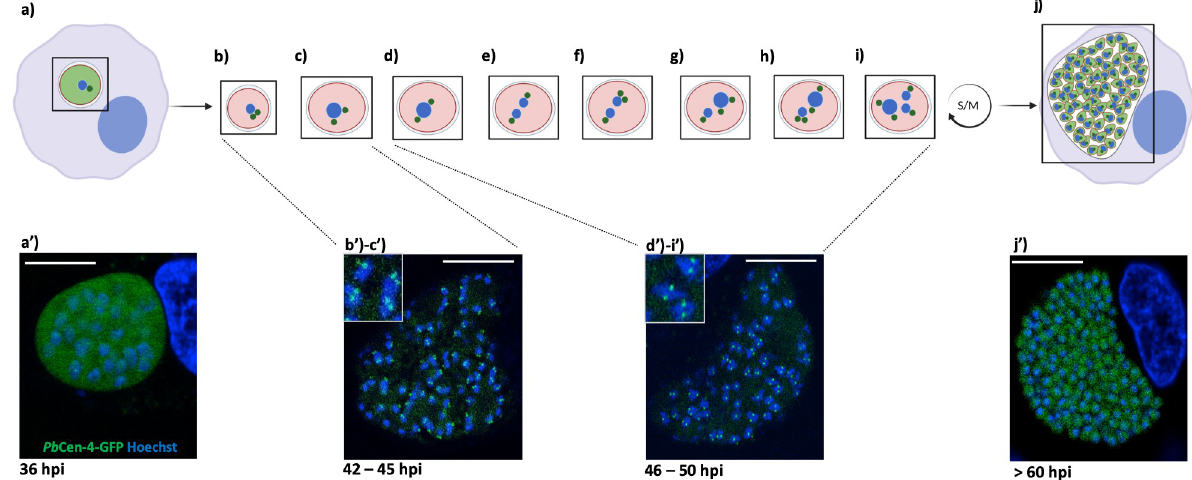
Fig 4. Schematic representation of CPs with Pb Cen-4-GFP and nucleus behavior during LS Plasmodium schizogony. The scheme from (a) to (j) represents Plasmodium nuclear and CP duplication and division through LS schizogony. Individual intracellular Plasmodium EEF (pink, from (b) to (i) ; green light in (a) and (j) ) surrounded by the PVM (light gray) within a hepatocyte (light blue) and the parasite CP (dark green) that is represented as a dot proximal to the parasite nucleus (blue). Corresponding live cell confocal images to this scheme represent prominent Plasmodium LS developmental stages (hpi: hours post-sporozoite infection into host cell): as early schizont (a’) , progression of schizogony (mid-schizogony) from (b’) to (c’) , late schizogony/beginning of cytomere stage from (d’) to (i’) , and finally end of merogony (merozoites formation) (j’) . These images represent endogenous tagging of Pb Cen-4 (PBANKA_0941400, CP marker) in fusion with a GFP fluorescent marker at its C-terminus (GFP, green) during LS development. Parasite and host cell nucleus are stained with Hoechst 33342 (blue). The transgenic parasite line has been generated previously [8]. HeLa cells were infected with Pb Cen-4-GFP expressing salivary gland sporozoites. Images represent the progression of Plasmodiu m nuclear division through schizogony. For a better comprehension, 2 S/M asynchronous rounds where an early schizont stage duplicates its CP have been presented (b); the 2 CPs move at the opposite part of the starting duplicating nucleus (c), (d), from (b’) to (c’) and from (d’) to (i’) to finally be present as a dot close to each individual separated nuclei (e). The S/M alternative phases (represented by the arrow) are then repeated from (f) to (i) (second round of S/M represented here) until cytomere stage formation and merozoite formation in (j) and (j’). The scale bar for the early schizont image (a’) is 10 μ m and for the late schizonts (from (b’) to (c’); from (d’) to (i’)) and end of merozoites formation (j’) is 20 μ m (created with BioRender.com). CP, centriolar plaque; EEF, exoerythrocytic form; LS, liver stage; PVM, parasitophorous vacuole